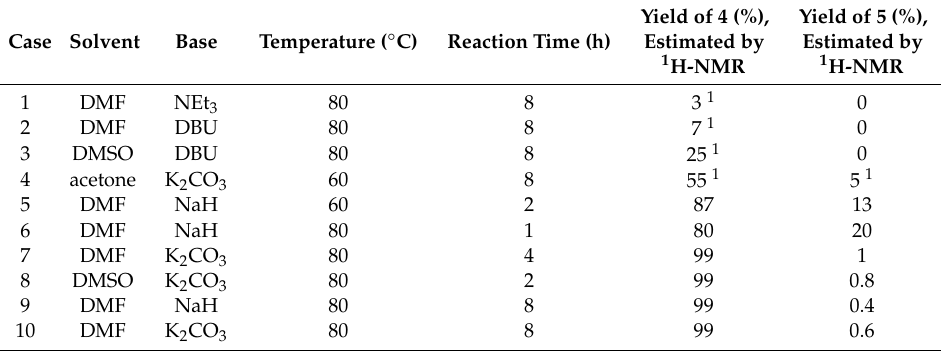
Table 1. The reaction conditions for methylation of compound 3 .